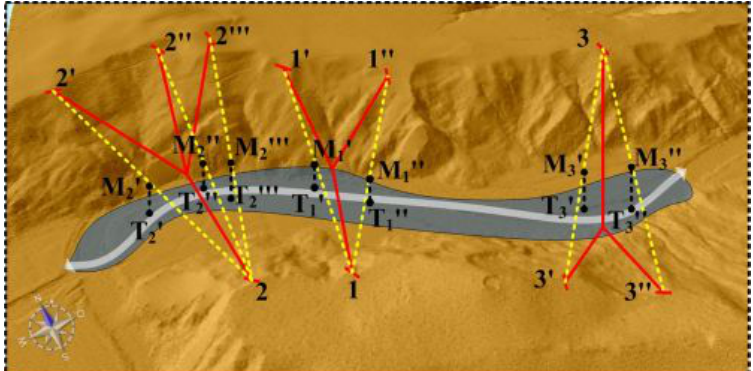
Figure 7. Several identified cross-sections (red) with their midpoints (M) and their projections on the terrain surface (T). Midpoints of the cross-sections longer than the parameter of the minimal width are merged into the region (grey) which skeleton line (white) is used for the length